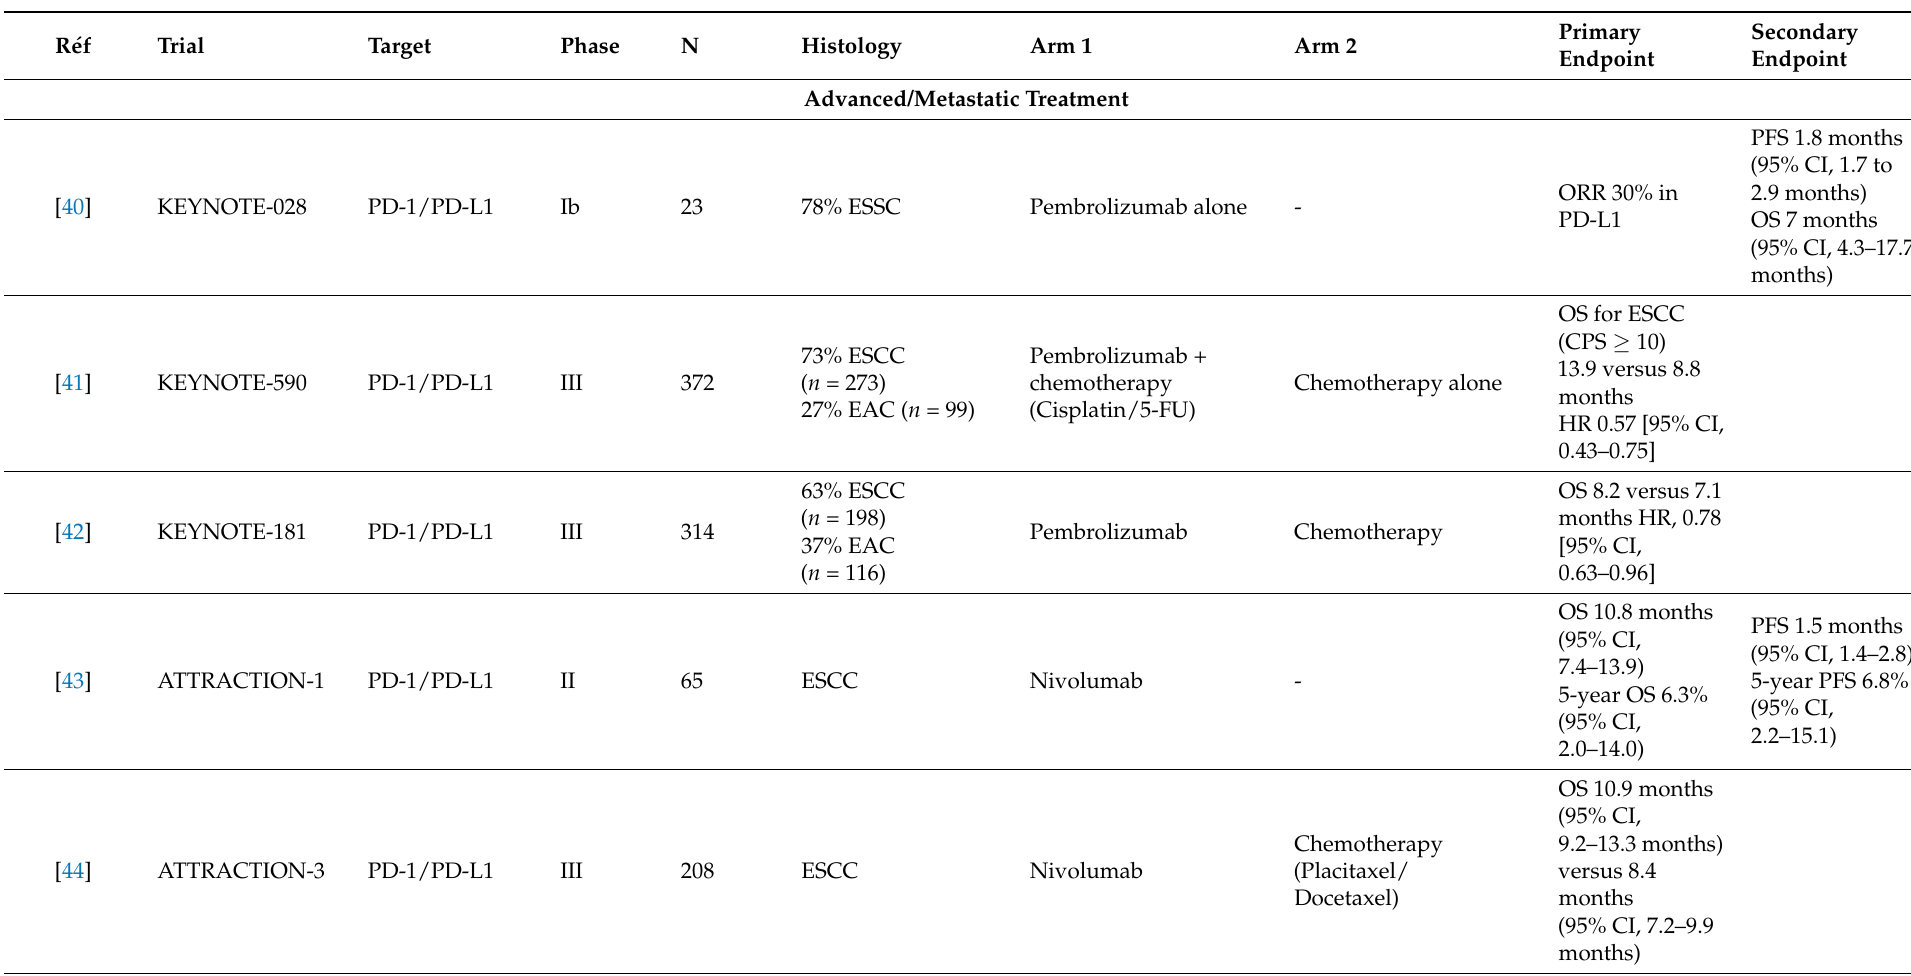
Table 1. Summary of published